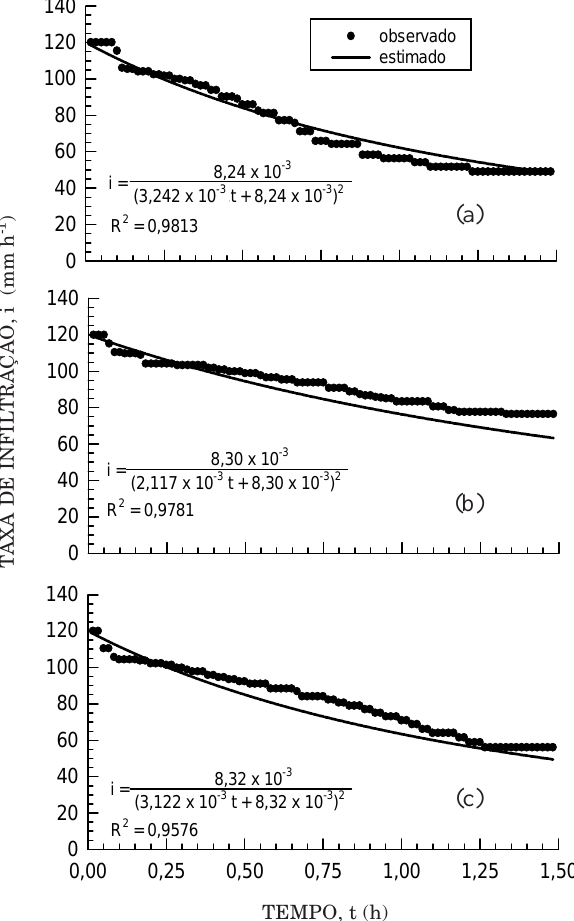
Figura 1. Taxa de infiltração observada e estimada durante os 90 minutos de chuva simulada para o preparo convencional (a), cultivo mínimo (b) e sistema plantio direto (c), 45 dias após a semeadura do milho (novembro/1994).